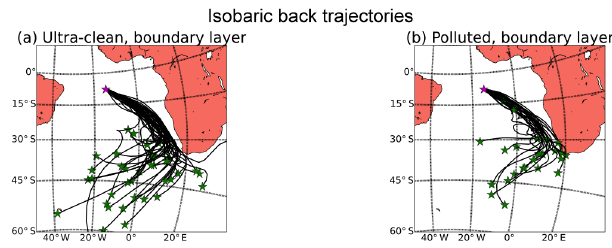
Figure 3. Isobaric 7d HYSPLIT back trajectories at 500m for (a) ultra-clean and (b) polluted days from ASI.